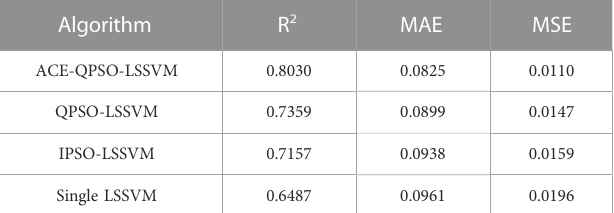
TABLE 7 Comparison of performance metrics for each algorithm. Algorithm R 2 MAE